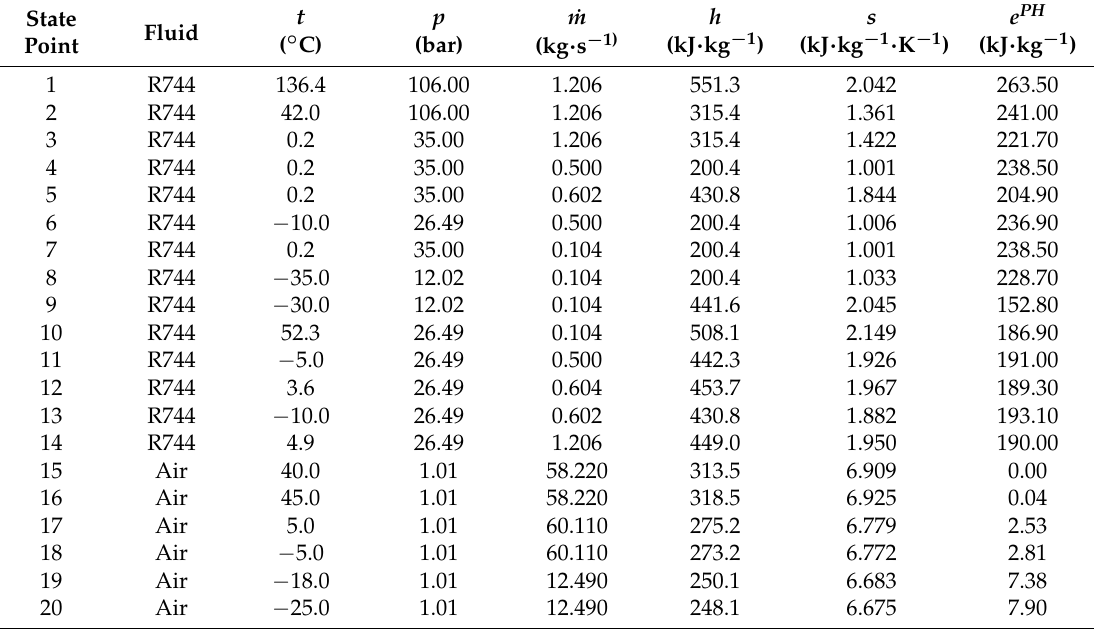
Table 7 summarized temperature, pressure, mass flow rate, specific enthalpy, specific entropy, and specific flow exergy at the outdoor temperatures of 40 ◦ C of the real thermodynamic cycle of CB. Table 7. Thermodynamic parameters of CB at the outdoor temperature of 40 ◦ C calculated in real